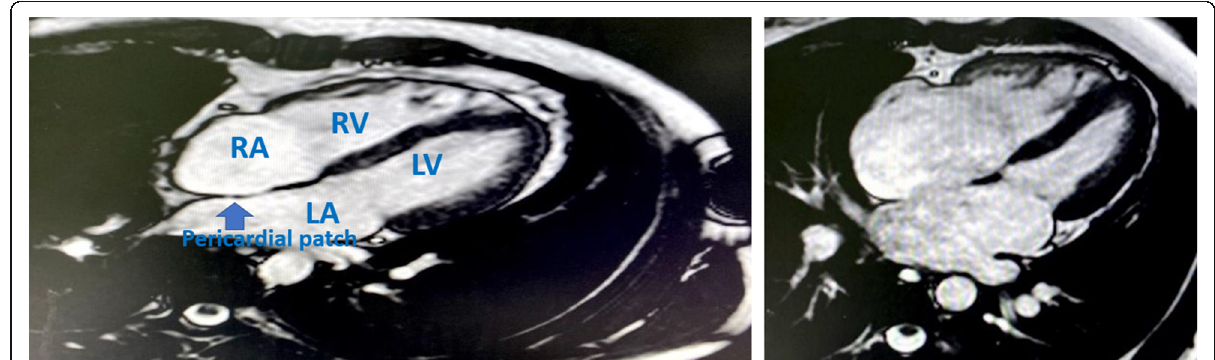
Fig. 5 Cine SSFP 4 chamber MRI view in surgically closed case by conventional method with revolution of RA and RV